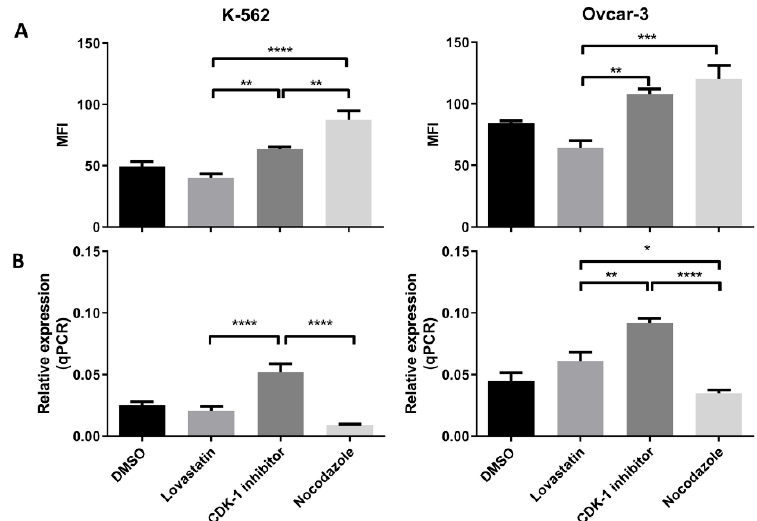
Figure 4. HLA-G (protein and mRNA) expression by K-562 and OVCAR-3. ( A ). Mean fluorescence intensity (MFI) using mode fluorescence intensity is shown for the two cell lines. DMSO-treated cells are shown as a control with unsynchronized cells. Nocodazole-treated cells have the highest expression of HLA-G protein in each of the cell lines while lovastatin-treated cells showed the lowest expression, not di ff erent to unsynchronized cells. The CDK-1 inhibitor-treated cells showed intermediate expression for K-562 cells while for OVCAR-3 cells, expression was higher than lovastatin-treated cells but not di ff erent than nocodazole-treated cells. ( B ). qPCR analysis showed that both cell lines express higher gene expression when treated with CDK-1 inhibitor (G2 phase) compared to lovastatin (G1) and nocodazole (mitotic)-treated cells. No di ff erence was observed for gene expression in lovastatin (G1)-treated cells compared to nocodazole (mitotic)-treated cells in K-562 cell line. However, OVCAR-3 cells showed the lowest mRNA expression in nocodazole-treated cells that was significantly lower than lovastatin-treated cells (One-Way ANOVA; Tukey’s test * < 0.05, ** < 0.005, *** < 0.001, **** < 0.0001).